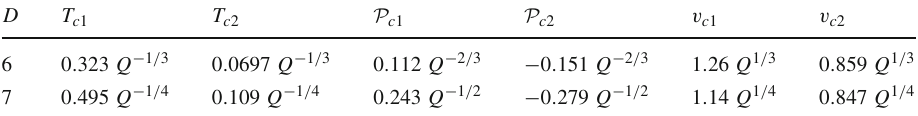
Fig. 2 Isotherms in P – v diagram of charged dilatonic AdS black hole with N = 2 , D = 6. We set the electric charge Q = 10. The two black points represent the critical points and the two blue points represent incompressible points at critical